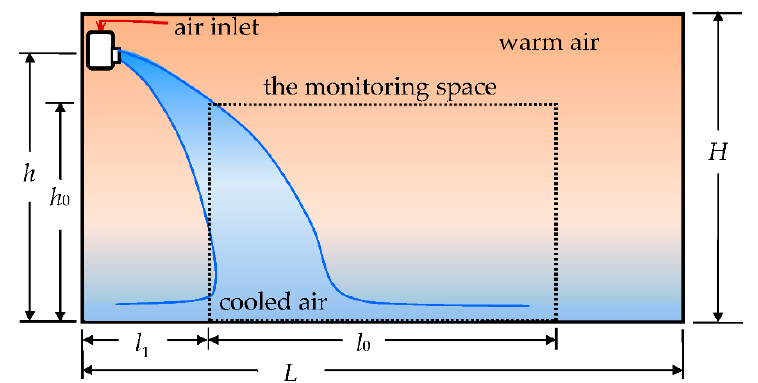
Figure 1. Configuration of the room air-conditioning system at the early stages of operation and the flow formed by an inclined buoyant jet from the cold air leaving the device exit. The blue colour corresponds to cold air and orange to warm air. The dotted line shows the space where the air temperature has been monitored.